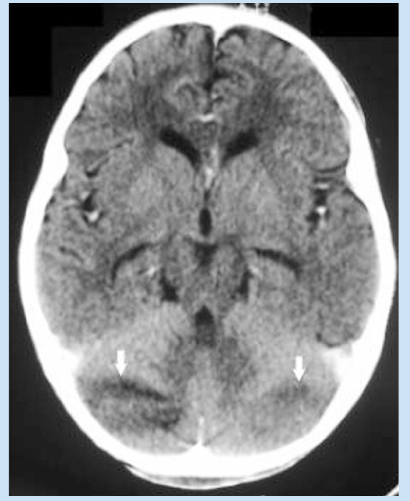
Fig. 4. Axial post-contrast CT scan of the brain demonstrates bilateral assymetrical hypodensities in the cortical and subcortical regions of the cere- bellar hemispheres with no associated enhance- ment